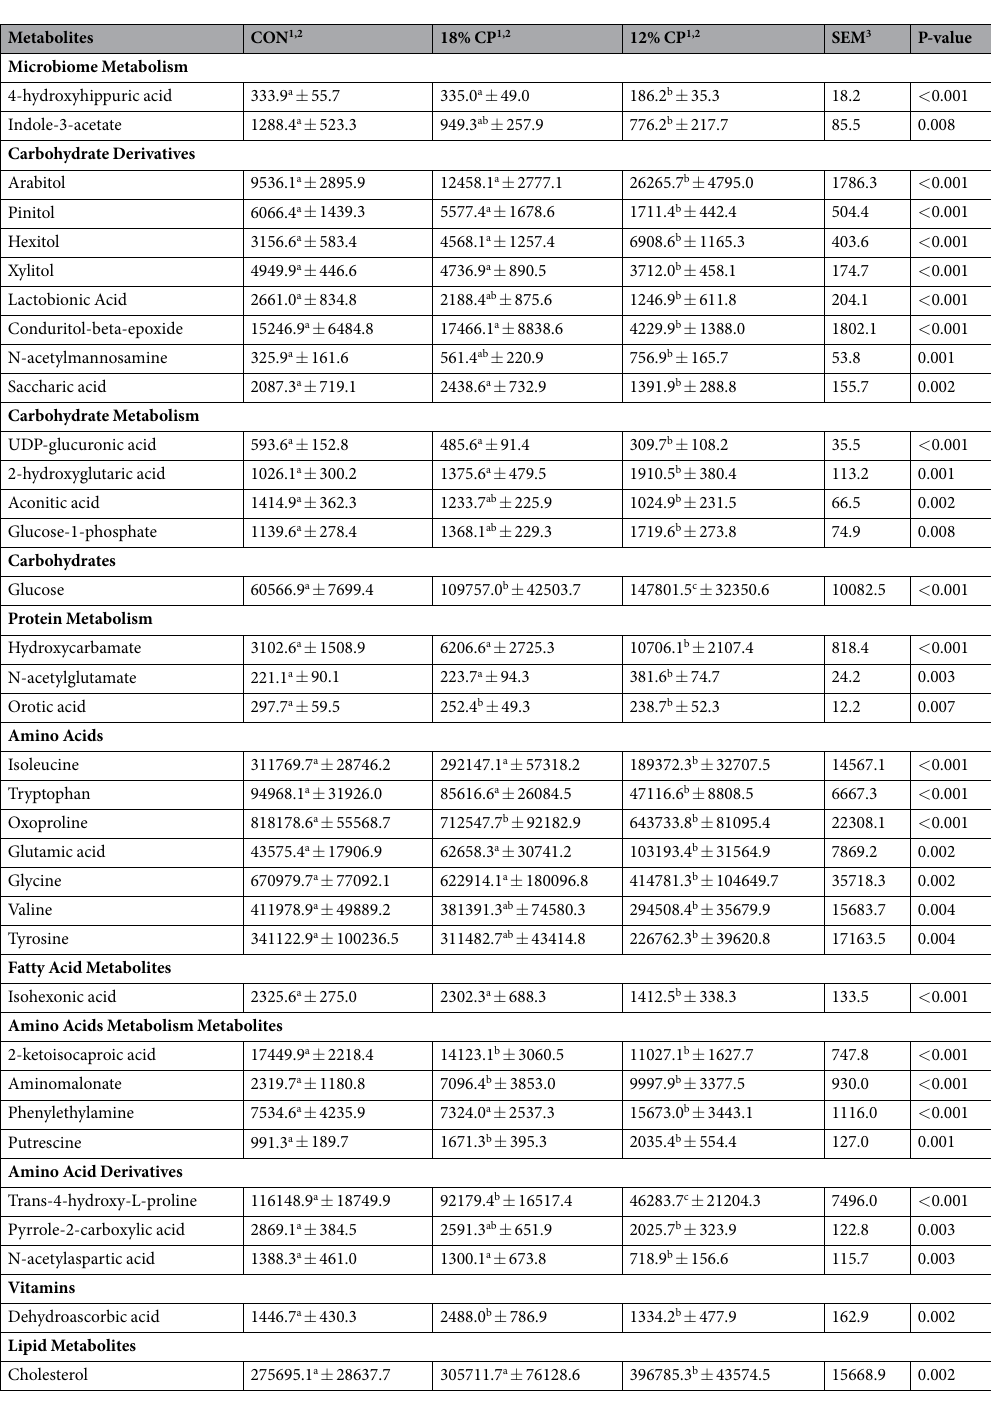
Table 2. Effect of dietary protein content on blood metabolomics profile. 1 CON, control diet with 24% crude protein (CP); 18% CP, low protein diet with 18% CP; 12% CP, low protein diet with 12% CP. 2 Average peak height. 3 SEM: standard errors of means. a,b Within a row, values with different superscripts are different (P < 0.05). The values are the mean ± standard